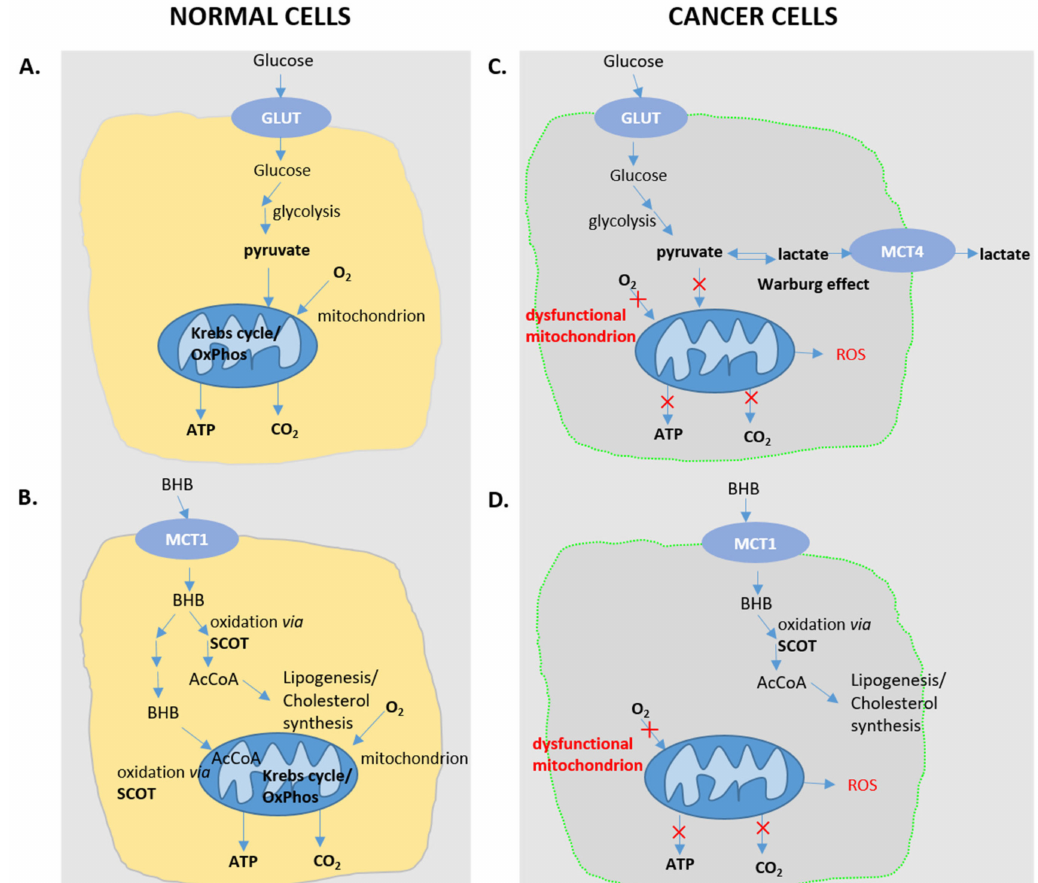
Figure 3. Selective use of ketone bodies by normal, non-cancerous cells can allow bypassing the glucose-induced Warburg e ff ect in cancer cells. ( A ) In normal cells, glucose is fully oxidized through glycolysis followed by the mitochondrial Krebs cycle coupled to oxidative phosphorylation. ( C ) In cancer cells, pyruvate (the last metabolic intermediate of glycolysis) is reduced to lactate, which may serve as a precursor to sustain biosynthetic pathways. ( B , D ) Under conditions of glucose depletion, insulin deficiency, ketogenic diet or prolonged intensive physical activity, glucose becomes limited and cells resort to the use of ketone bodies, including BHB. ( B ) In normal cells, BHB can sustain extra mitochondrial biosynthetic pathways and serve as a AcCoA source to feed the Krebs cycle. ( D ) In cancer cells, the replacement of glucose as the primary energy source with ketone bodies (BHB) enables blunting the Warburg e ff ect and tumor cell growth. (GLUT, glucose transporter; MCT monocarboxylate transporter; OxPhos, oxidative phosphorylation; SCOT, Succinyl-CoA: 3-ketoacid CoA transferase; ROS, reactive oxygen species; AcAc,